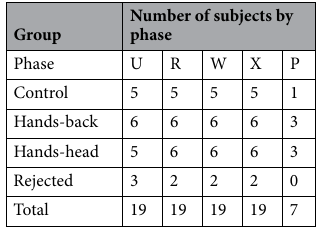
Table 1. Summary of the data that was collected for this study and the data that was analyzed for each treatment group and for each phase.